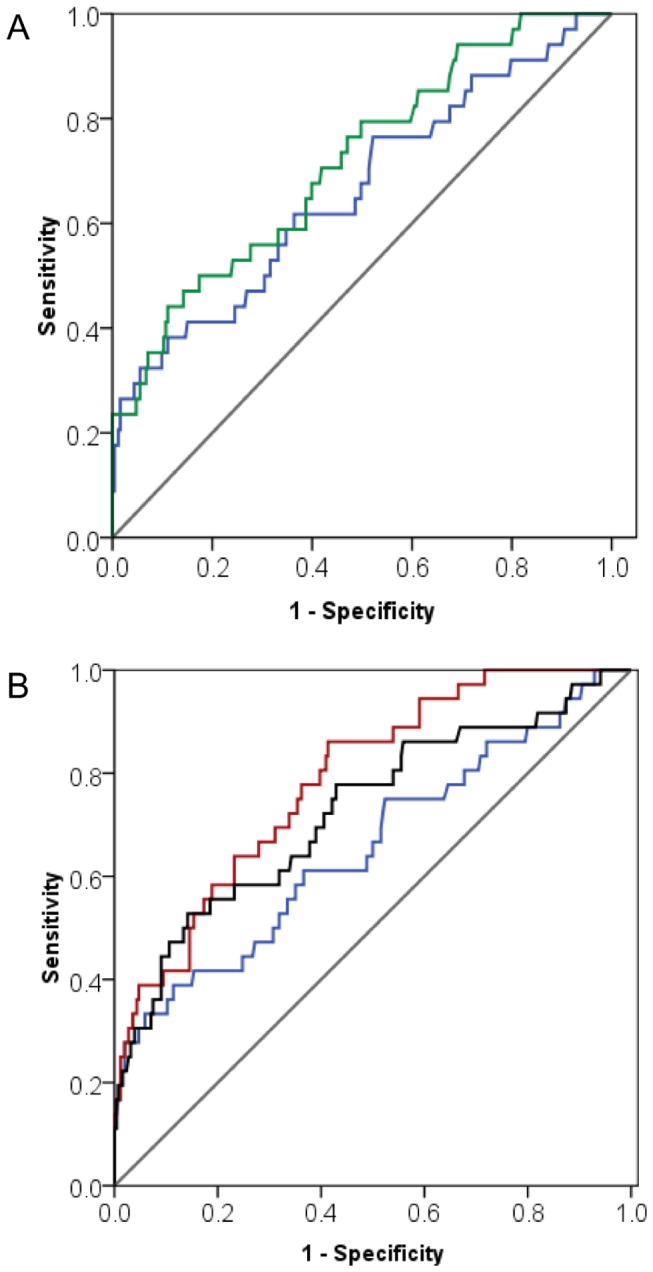
ROC curve analysis.A: ROC curves for TnT assessed at 6 to 8 hours post-surgery (AUC: 0.663; blue line) versus 20 hours (AUC: 0.717; green line).B: ROC curves for TnT assessed at 6 to 8 hours post-surgery when considered alone (AUC 0.663; blue line), together with the need of vasopressors during the first 6 hours post-surgery (AUC: 0.726; black line), and the preoperative EuroSCORE (AUC: 0.786 red line).